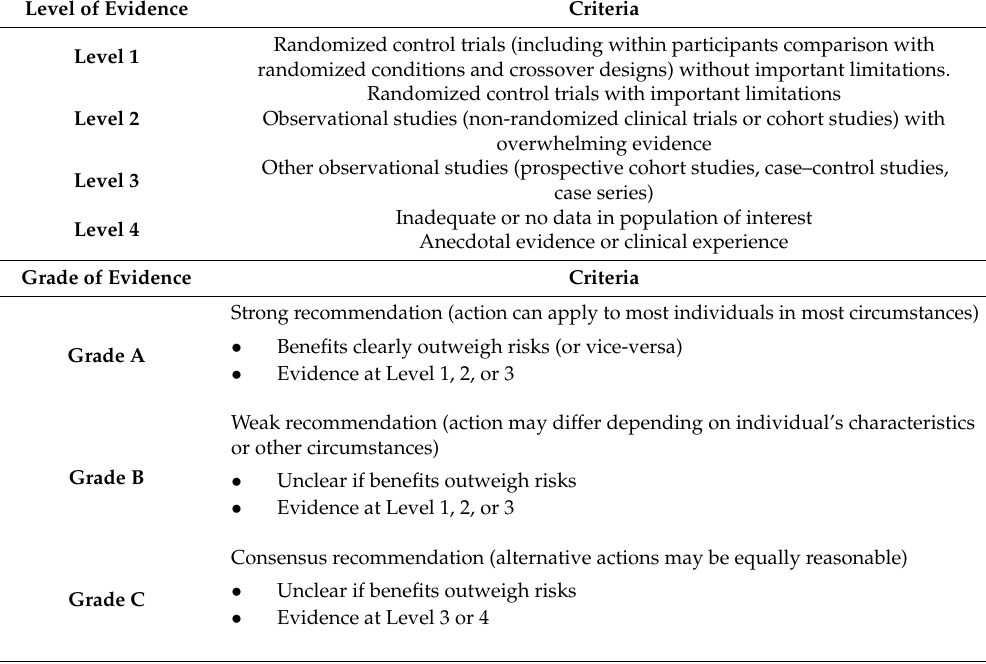
Table 2. Level and grade of evidence criteria for the evaluation of studies and creation of